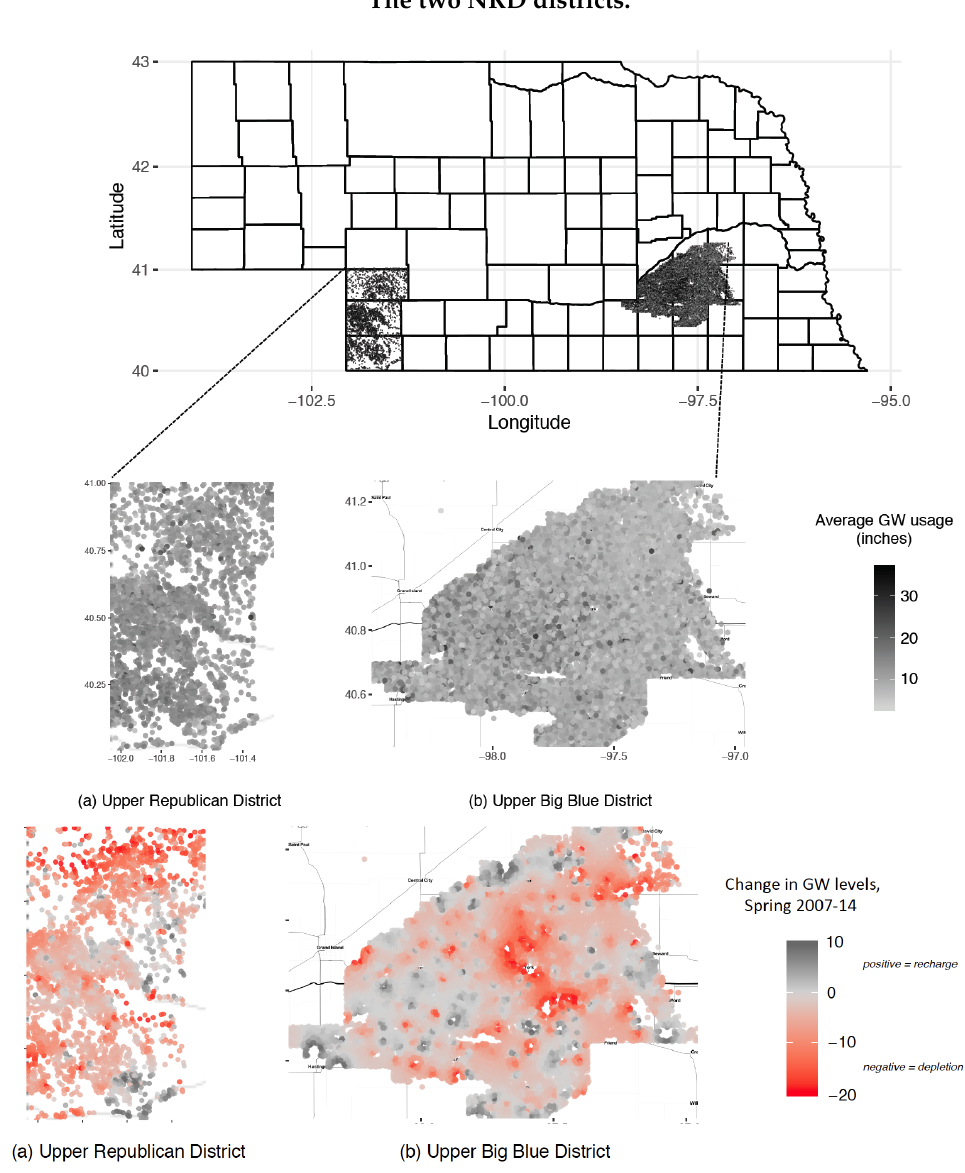
Figure 1. Top : Water-per-acre mean usages (all data). Bottom : Well-by-well change in groundwater levels (restricted to years 2007–14). Both are quantified in inches, where each inch corresponds to 27,157 gallons of groundwater, the amount needed to add one inch of water on top of one acre of